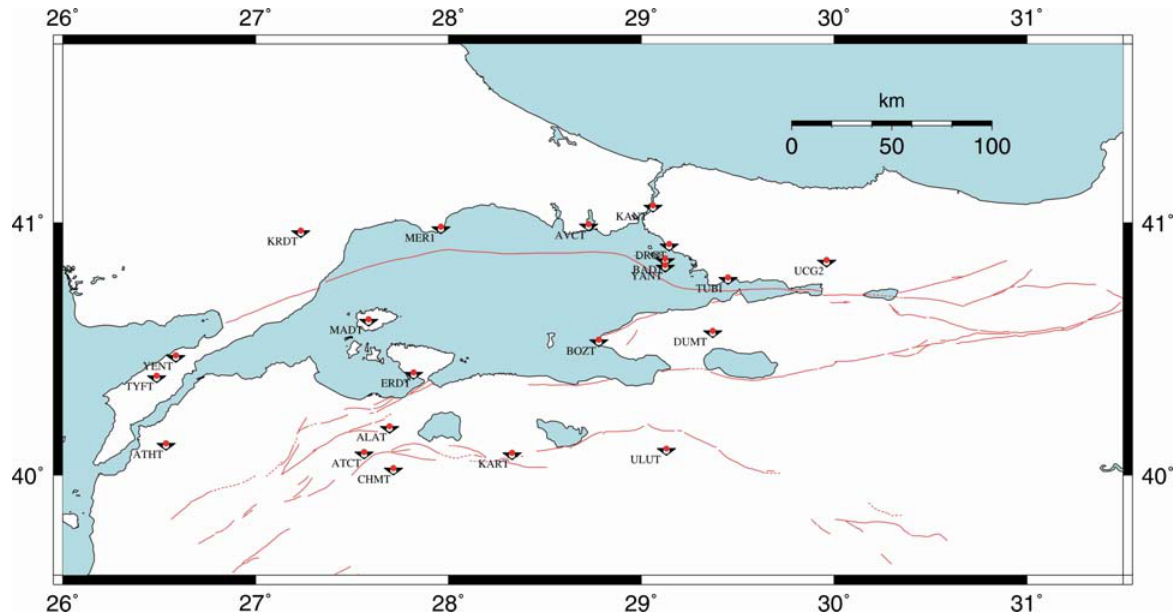
Figure 1. Location of GPS Sensors of MAGNET in Marmara Region (map produced by TUBITAK-MRC). Red lines indicate fault lines in the